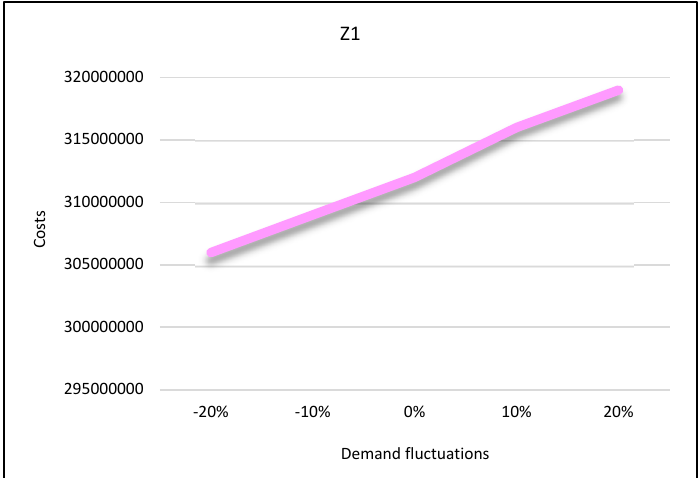
Figure 27. Demand variation effect on first objective function.